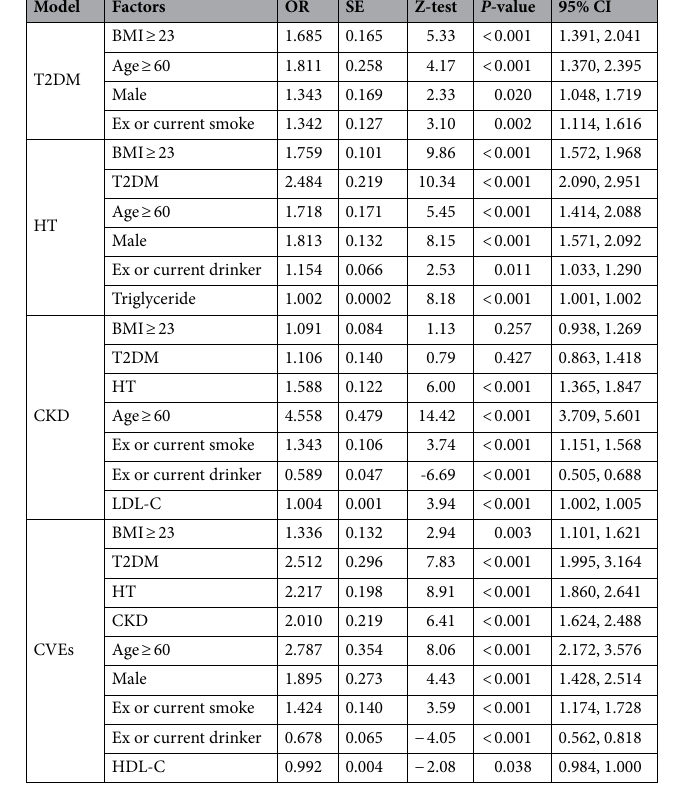
Table 4. Factors associated with mediators and cardiovascular events outcome: multivariate GSEMs. Abbreviations as in Table 1. CI confident interval, OR odd ratio, SE standard deviation.